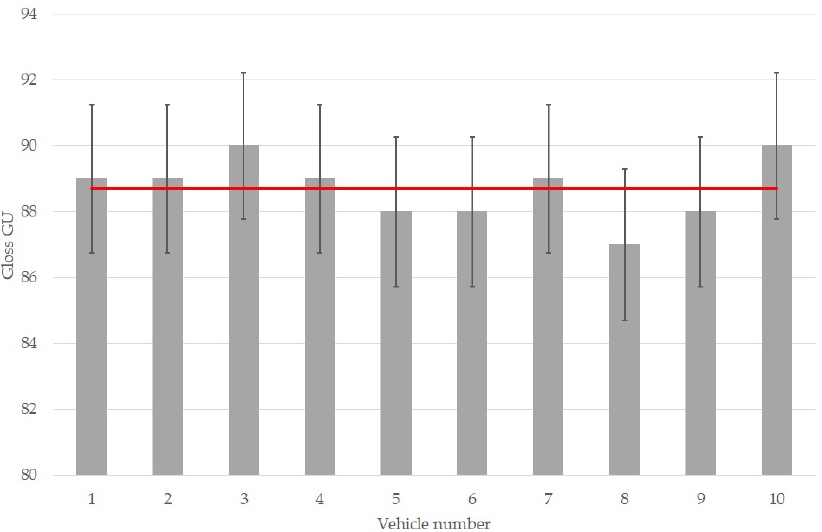
Figure 10. Average coating gloss values on the vehicle front left fender for delivery vehicle (for all 10 vehicles), by the blue line, the mean value from 10 vehicles is added. The value of the average gloss for the entire vehicle is 88.8 GU for a commercial ve- hicle and 67.7 GU for a B segment vehicle (test in 20°). In the case of the B segment vehicle, there was a clearly higher mean standard deviation of the gloss value, which is 5.6 GU